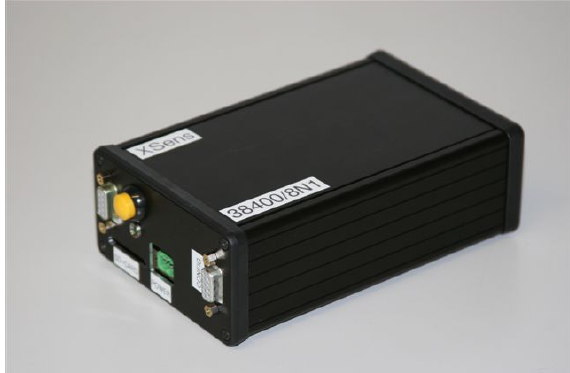
Figure 3: Picture of the magnetic data acquisition module devel- oped at Lucerne University for Applied Sciences and